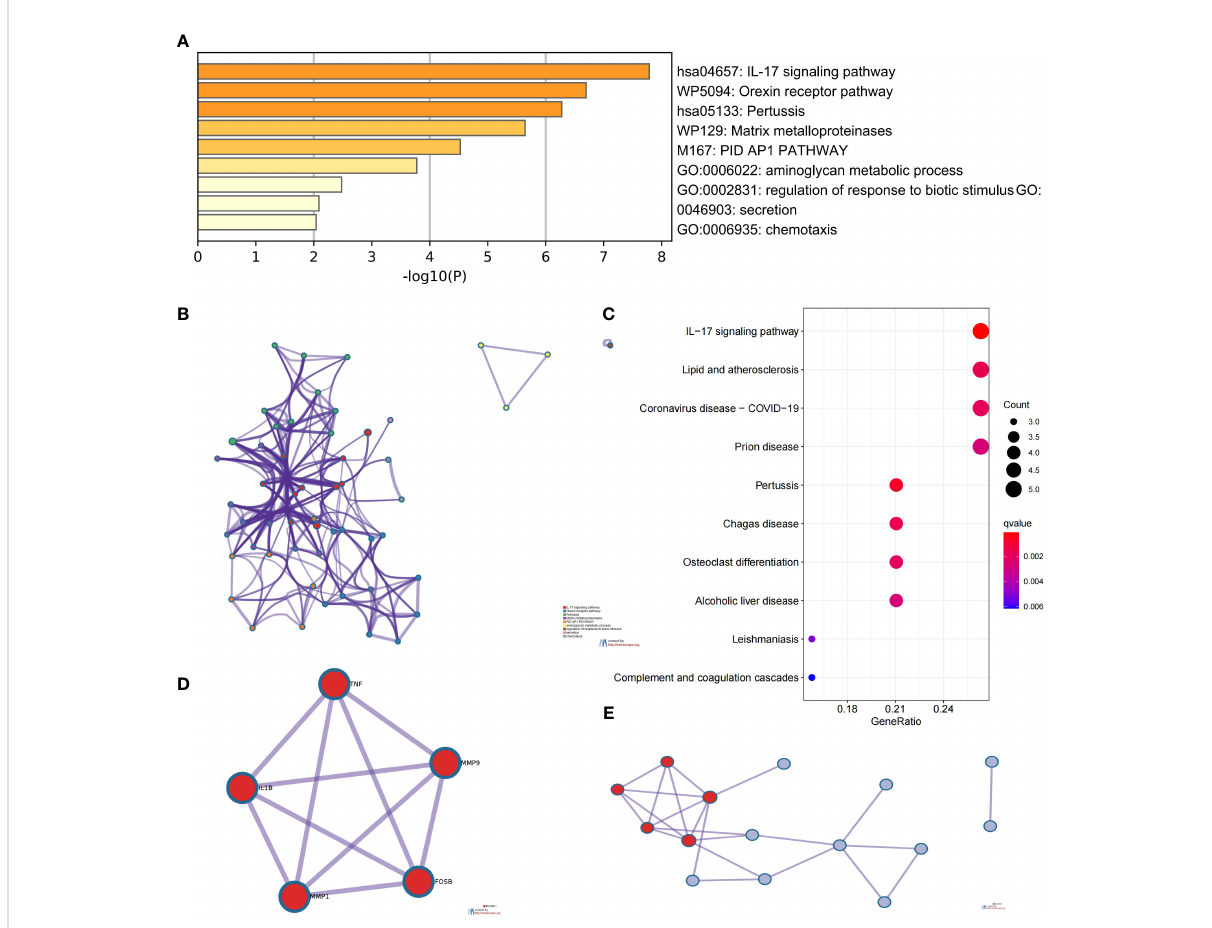
FIGURE 3 Analysis offunctional characteristics of common DEGs (CDEGs). (A) Bar chart of the CDEG functional enrichment analysis. (B) Network diagram of the CDEG functional enrichment analysis. (C) Results of the Kyoto Encyclopedia of Genes and Genomes ( KEGG) enrichment analysis of CDEGs. (D)